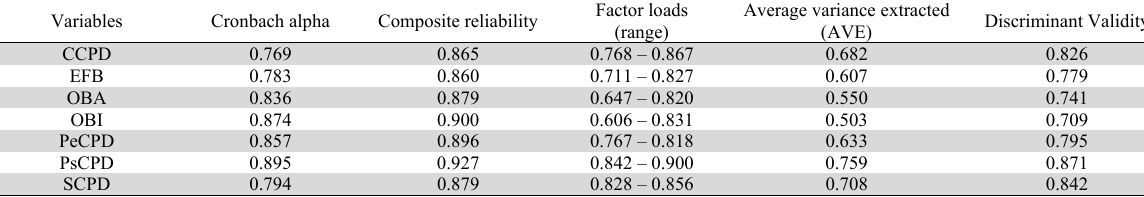
Results of the model measurement analysis